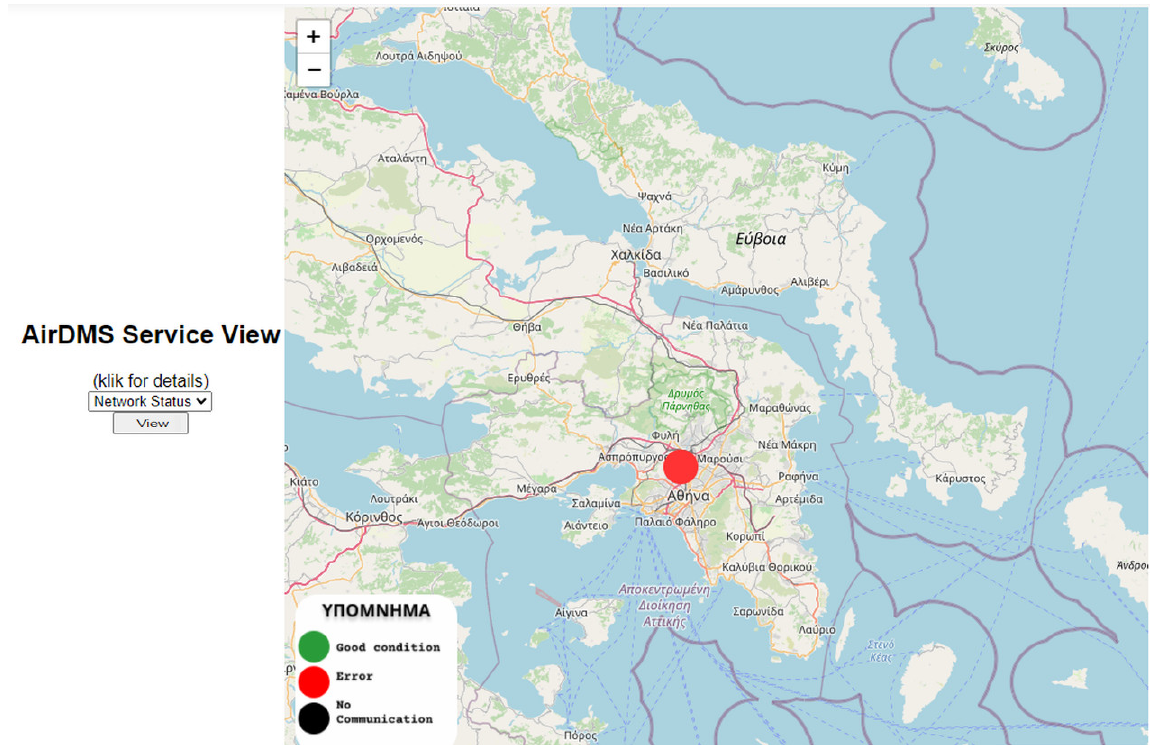
Figure 9. Operating status of the network stations.